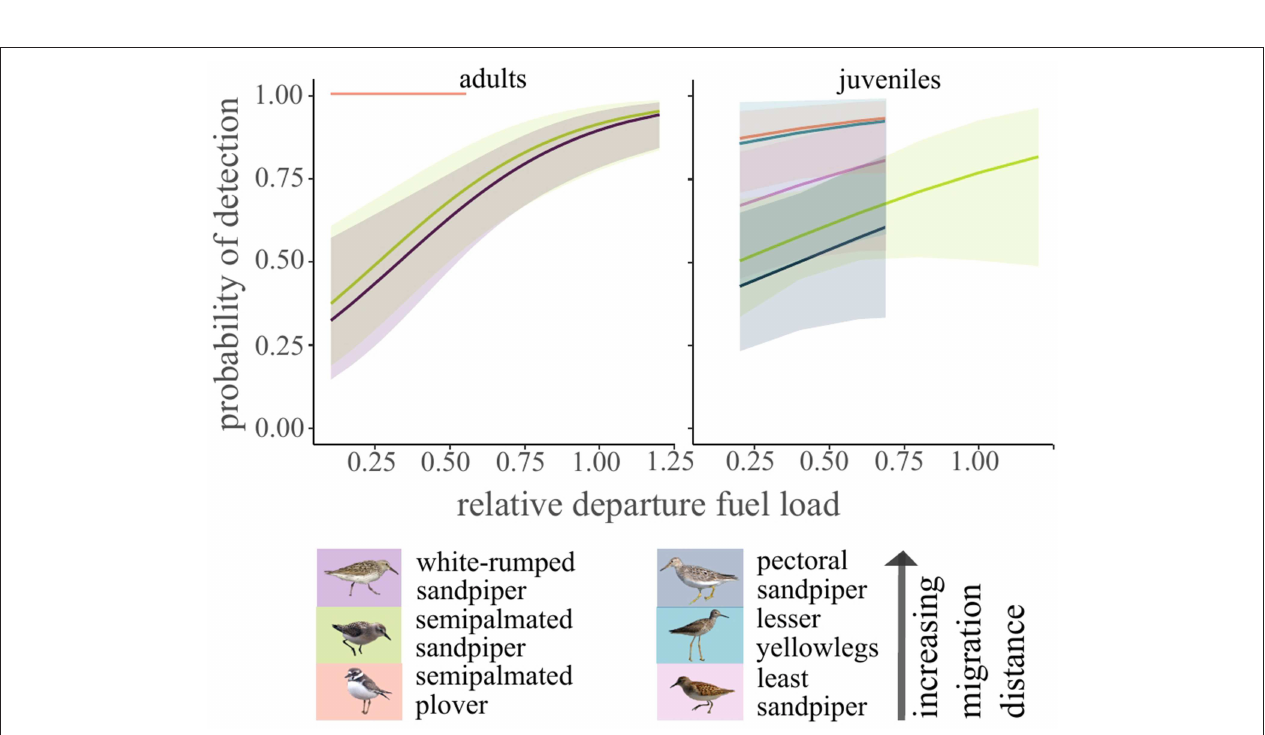
FIGURE 7 | Model predicted detection probability for shorebirds in North America after departing James Bay, Ontario, Canada in years 2014–2017. Relative fuel load at departure was a significant predictor for adults but not juveniles ( α = 0.05).